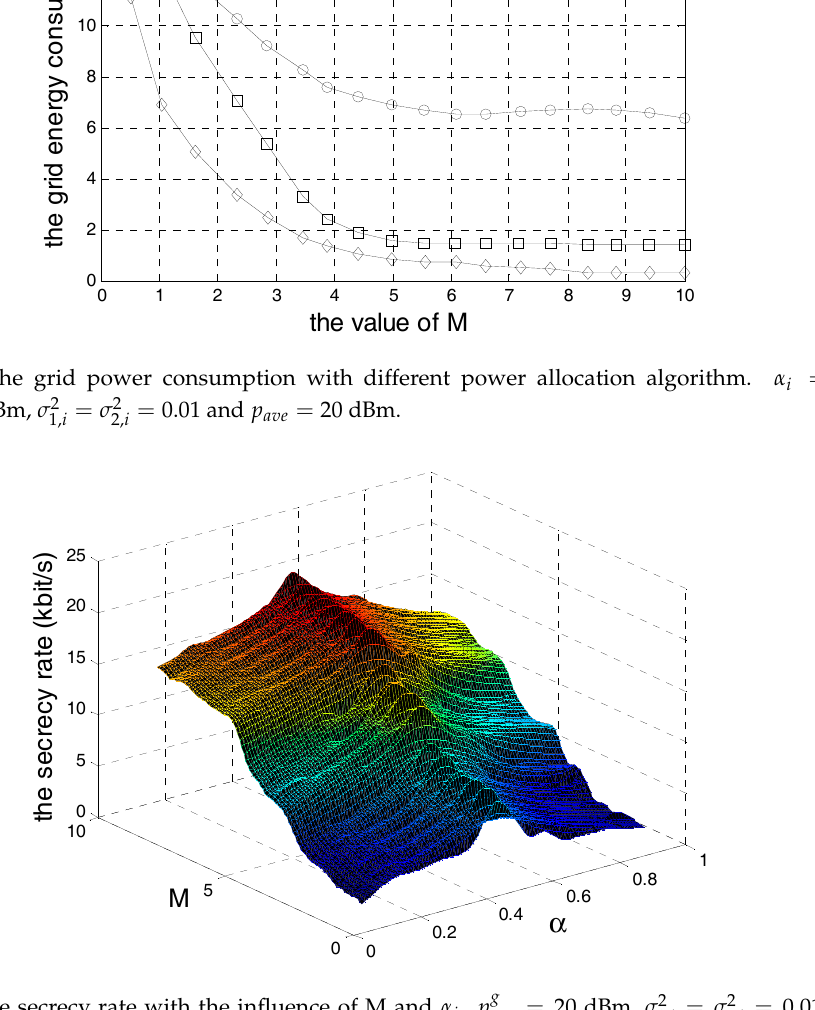
Figure 7. The secrecy rate with the influence of M and α i . p g ave = 20 dBm, σ 2